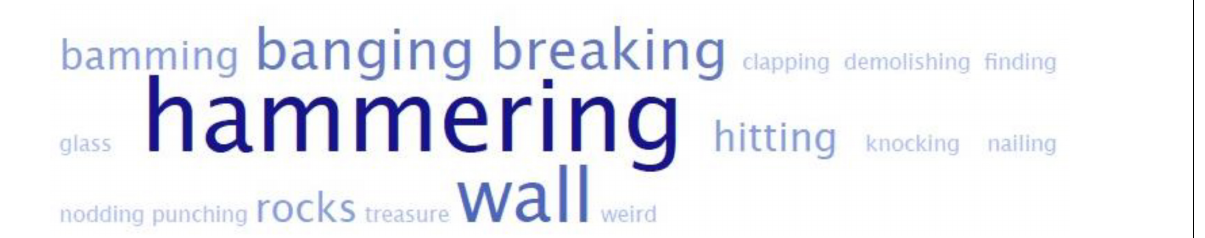
FIGURE 3 | Word cloud visualization for children’s responses ( n = 33) across both conditions in the production test to the item demolish . Words that appear larger in the word cloud were higher frequency